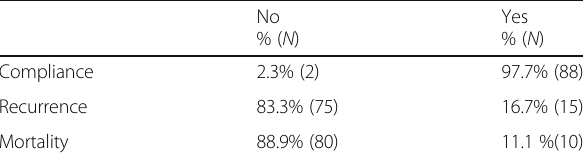
Table 1 Description of compliance, recurrence and mortality among